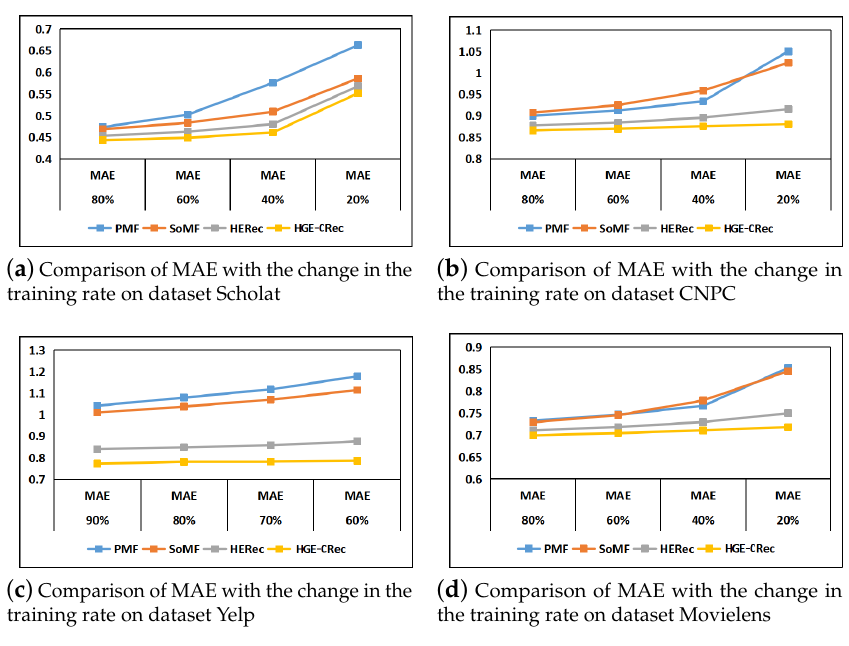
Figure 5. Comparison of MAE with the change in the training rate on four